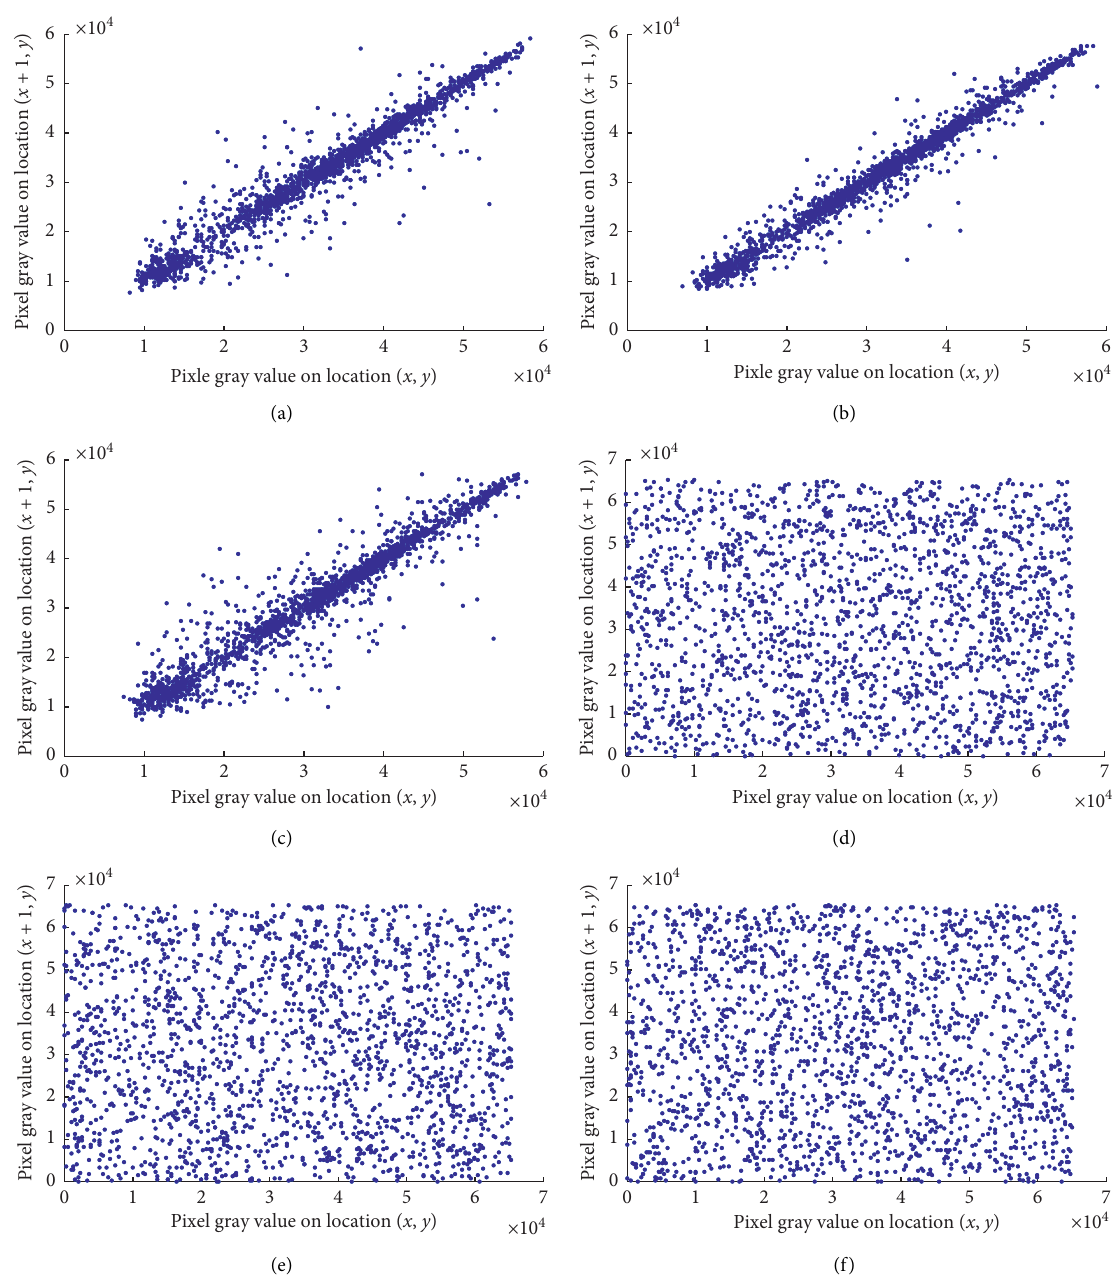
Figure 18: Adjacent pixels correlation test for Lena: (a) plain image by horizontal, (b) plain image by vertical, (c) plain image by diagonal, (d) cipher image by horizontal, (e) cipher image by vertical, and (f) cipher image by